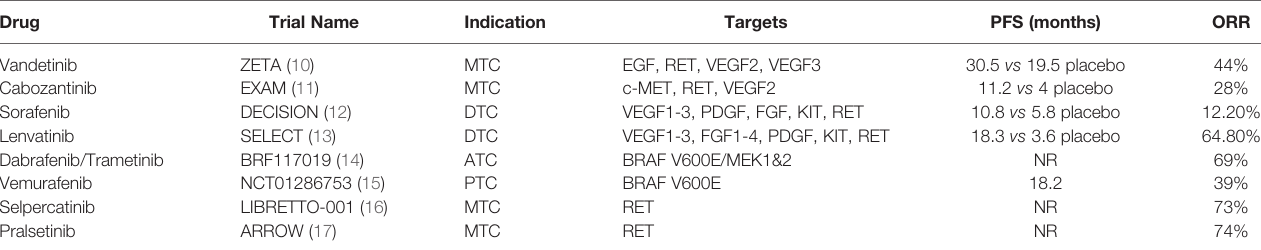
TABLE 1 | Tyrosine Kinase Inhibitors with Activity for Thyroid Cancers.